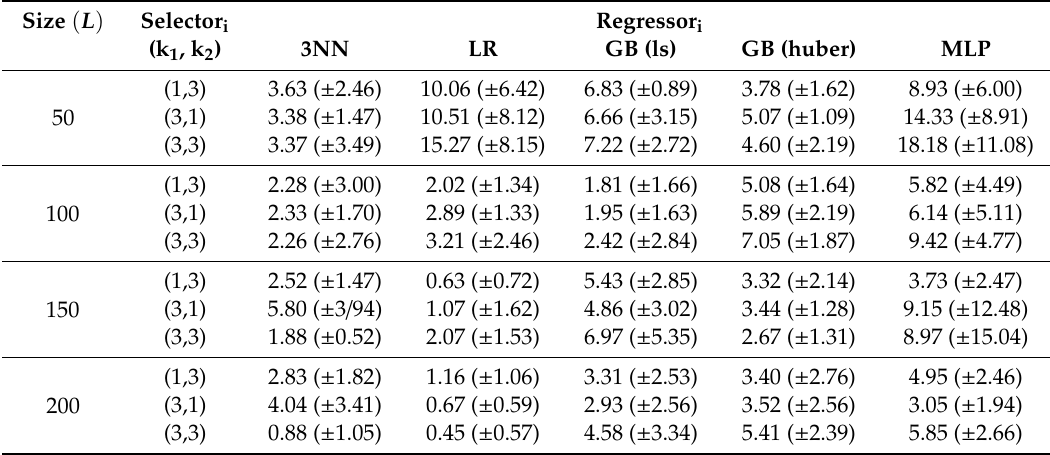
Table 4. Relative improvement of mean absolute error (MAE) metric ( ± std) of the dataset based only on the first semester during the best iteration per di ff erent combination of selector and regressor.